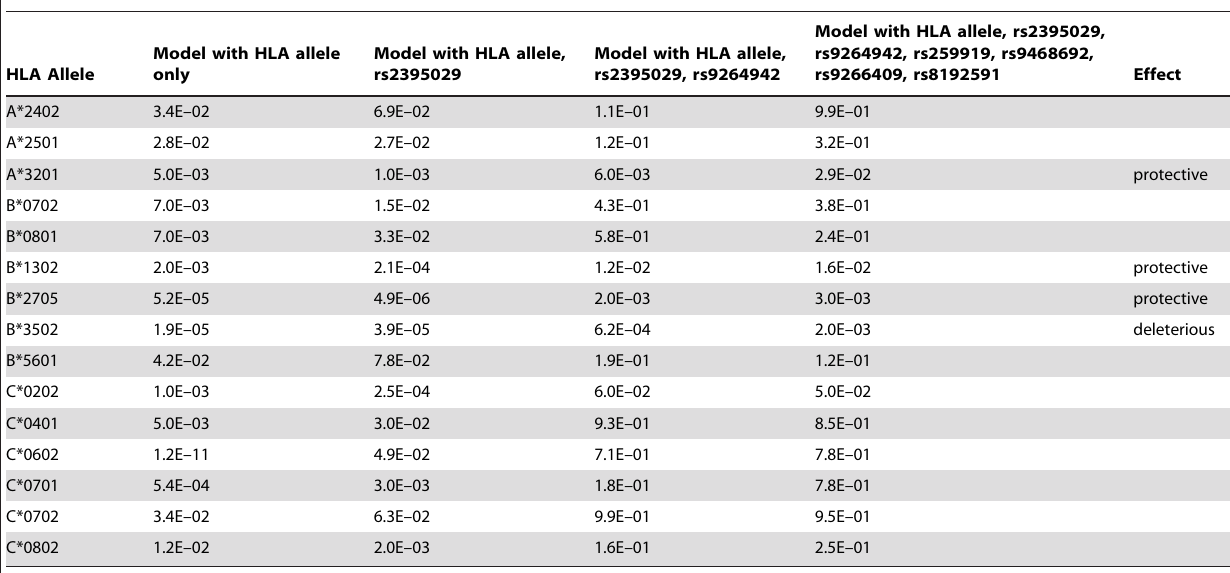
Table 2. Associations between 4-digit HLA Class I alleles and HIV-1 set point in a subset of 1,204 subjects with full results.